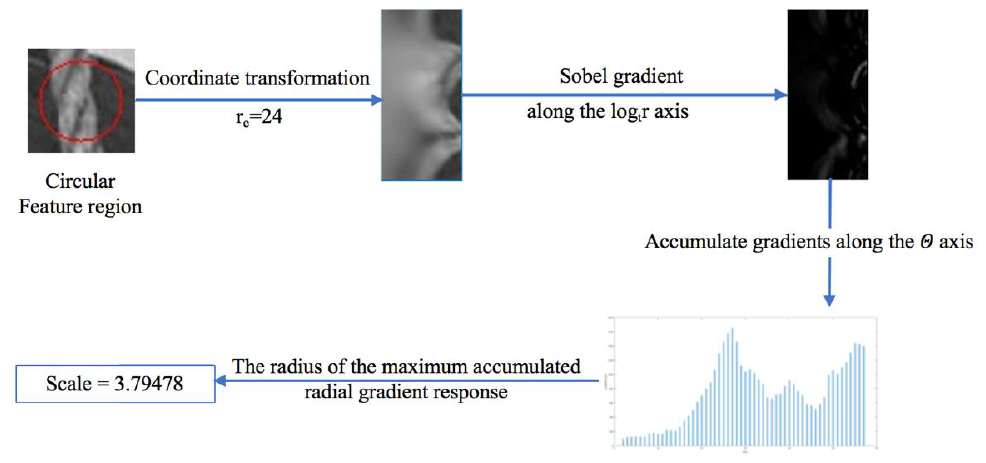
Figure 4. Scale representation estimation of a circular feature region.